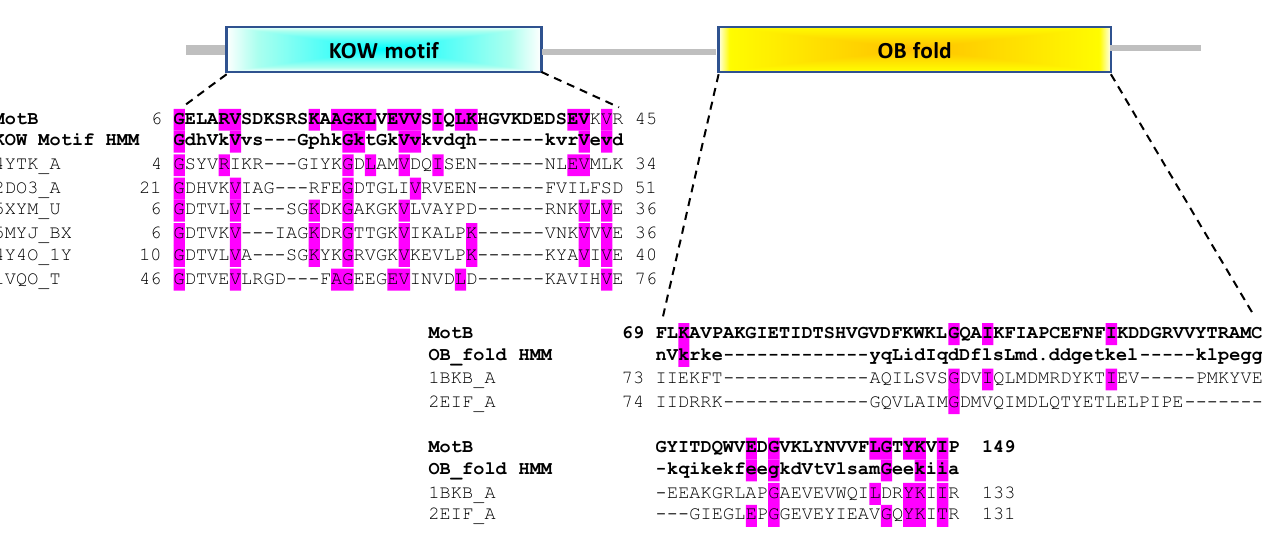
Figure 1. Domain organization of MotB predicts an N-terminal KOW and a C-terminal OB-fold domain. The Pfam Hidden Markov Model (HMM) consensus sequences of the KOW and OB-fold motifs are aligned with MotB residues 6 to 45 and 69 to 149, respectively, along with some other top hits for MotB found by HHsearch/HHpred (Table S3). For the KOW domain, these hits are PDB ID 4YTK, the KOW1-Linker1 domain of Saccharomyces cerevisiae Spt5 transcription elongation factor; 2DO3, the third KOW motif of human Spt5; and 5XYM, 4Y4O, 5MYJ, and 1VQO, ribosomal proteins of the bacteria Mycobacterium smegmatis, Thermus thermophilus and Lactococcus lactis and the archaean Haloarcula marismortui, respectively. For the OB-fold domain, these are 1BKB and 2EIF, the translation initiation factors 5A of the archaea Pyrobaculum aerophilum and Methanocaldococcus jannaschii , respectively. In each case identical residues within MotB and the consensus and/or MotB and the hits are highlighted in magenta. The alignment for the C-terminal portion of the third KOW motif of human Spt5 has been previously reported [41]. More information about the top 10 hits is given in Table S3.